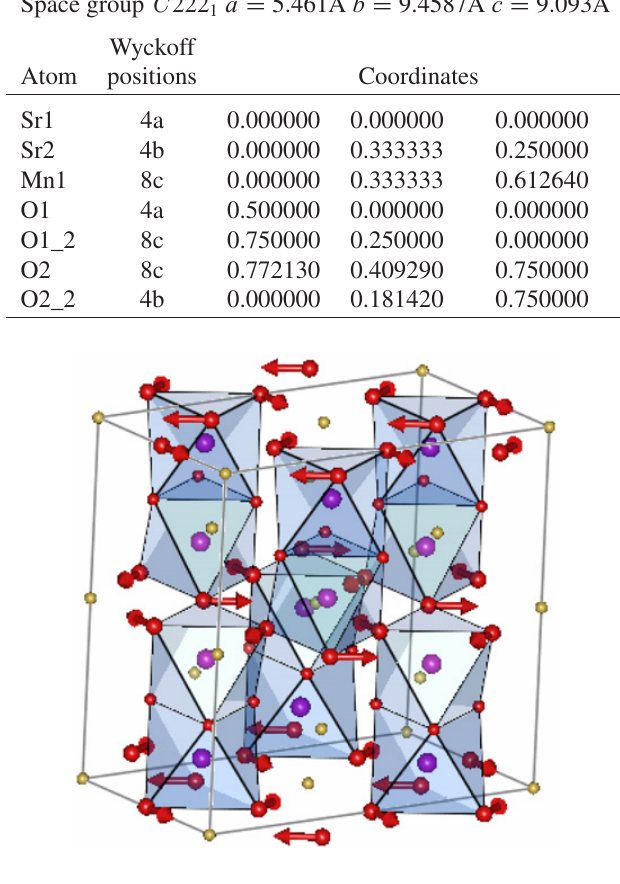
Figure 9. GM1-symmetry mode allowed in the C 222 1 phase of SrMnO 3 (figure done with FullProf Studio